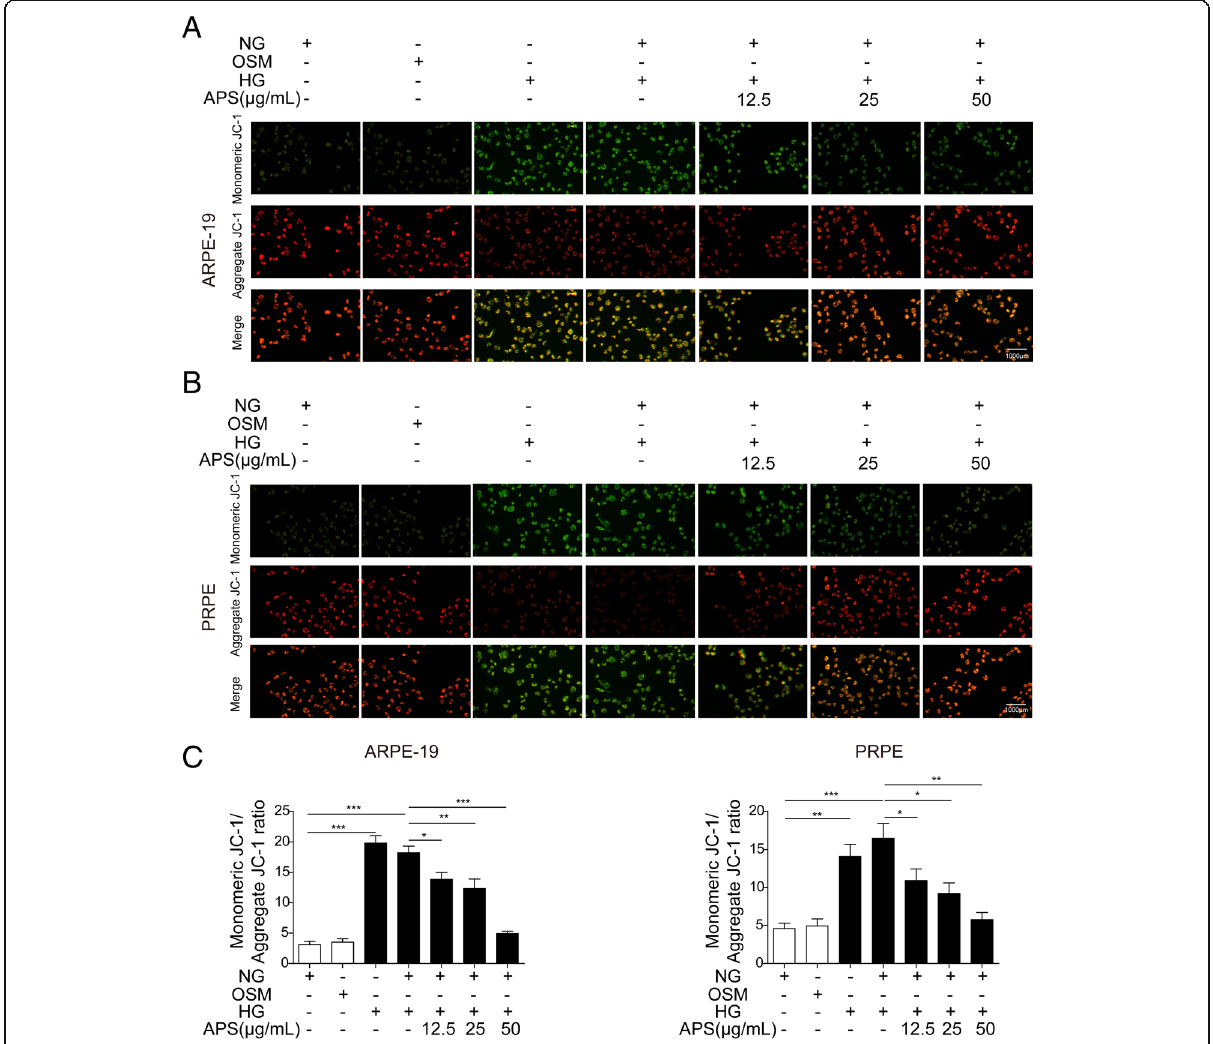
Fig. 4 APS ameliorated the mitochondrial membrane potential induced by HG in RPE cells. a Immunostaining showed treatment with APS significantly decreased the ratio of monomeric to aggregate JC-1 which was induced by HG or HG + NG treatment in ARPE-19 cells. b. Immunostaining showed treatment with APS significantly decreased the ratio of monomeric to aggregate JC-1 which was induced by HG or HG + NG treatment in PRPE. c The statistical results of the staining in A and B. Error bars represented mean ± SD. *** p < 0.001, ** p < 0.01, * p <